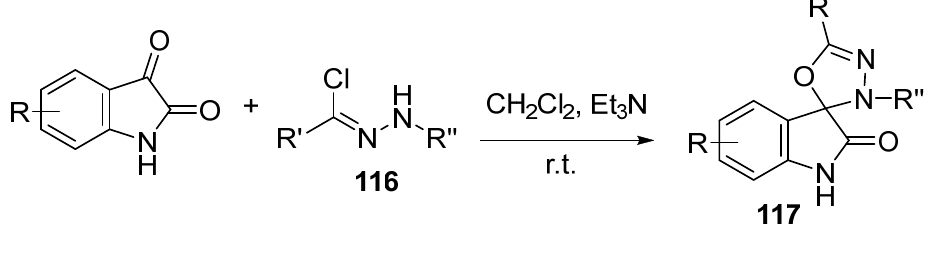
Scheme 40. Synthesis of Spiro[indoline-3,2 ′ -quinolins] 121 and spiro[indoline-3,5 ′ -pyrano[3,2- c]quinolins] 122